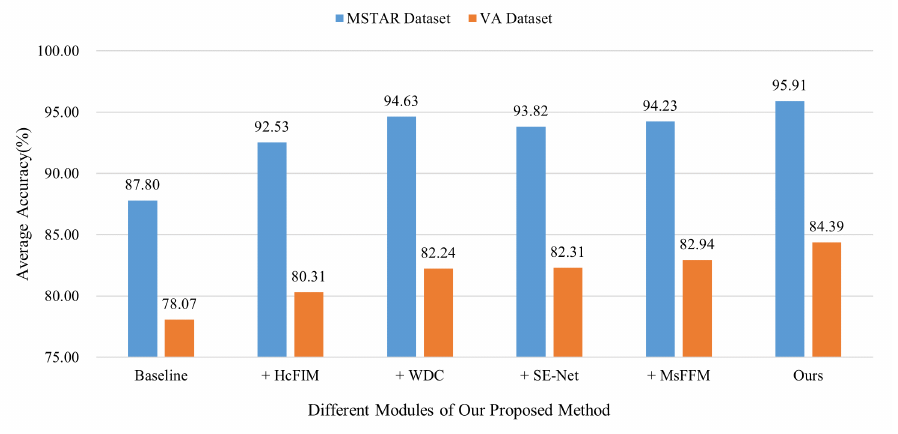
Figure 12. Results of the ablation study on both datasets.